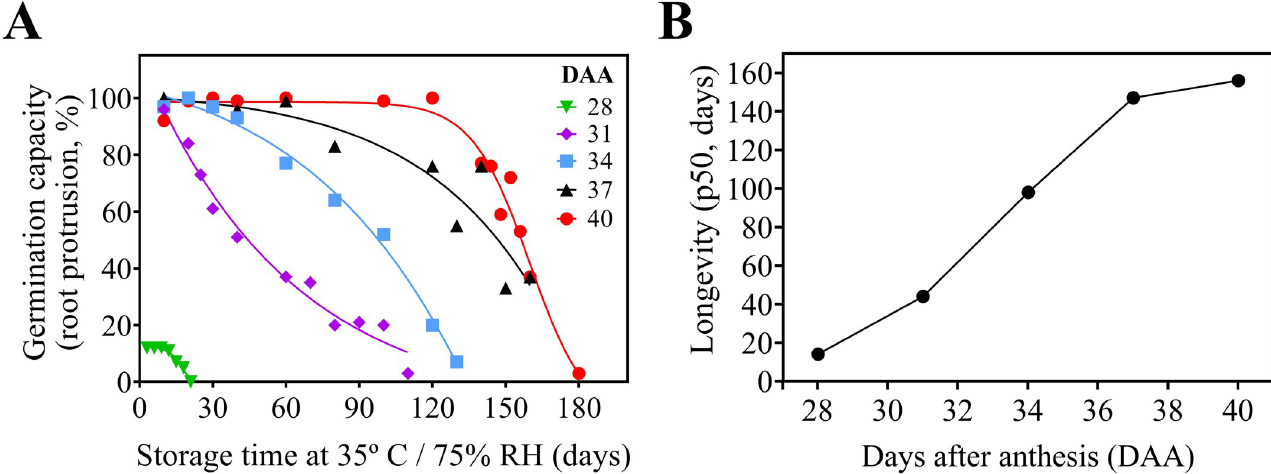
Fig 2. Lifespan of the cowpea ( Vigna unguiculata L., Walp) seeds harvested at 28, 31, 34, 37 and 40 DAA. A: Germination capacity after different periods of storage. B: acquisition of seed longevity expressed by p50 (period in days when the viability of the seeds is reduced by 50%).